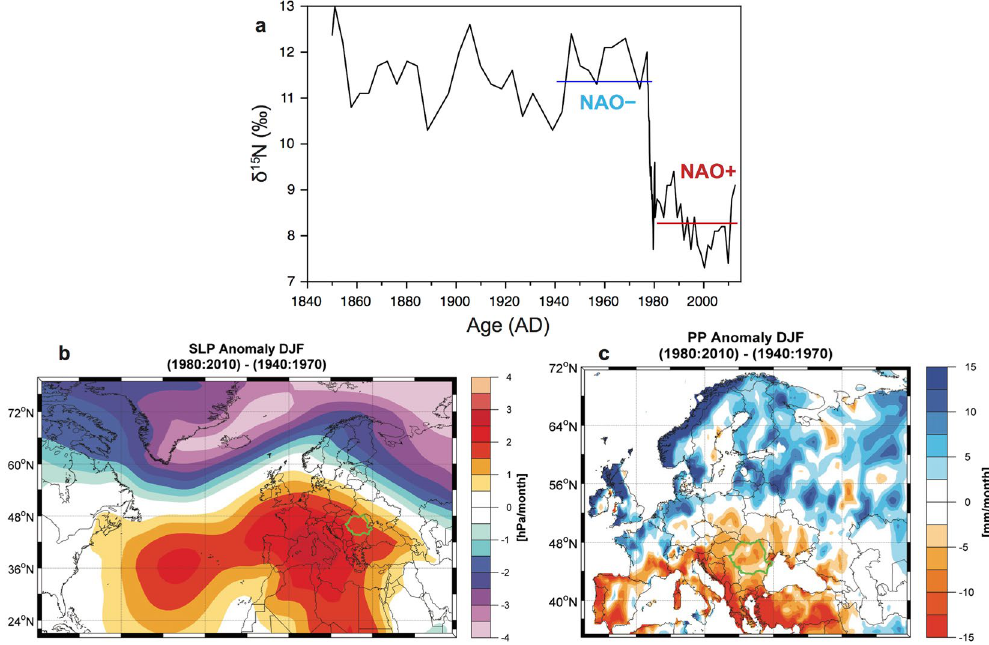
Figure 2. ( a ) δ 15 N of MC guano from 1850 to 2012 (see text for details). ( b ) The difference in the Sea Level Pressure between 1940 and 1970 (pre-shift) and the period 1980–2010 (post-shift) based on data from NCEP/ NCAR Reanalysis 55 . ( c ) As in ( b ) but for winter precipitation derived from CRU TS3.24.01 data set 54 . The figures were produced using ( a ) pro Fit 7.0 (http://www.quansoft.com) and ( b,c ) Matlab 2014b (http://de.mathworks. com/products/new_products/release2014b.html), respectively. The digital version was generated using Adobe Illustrator CC17